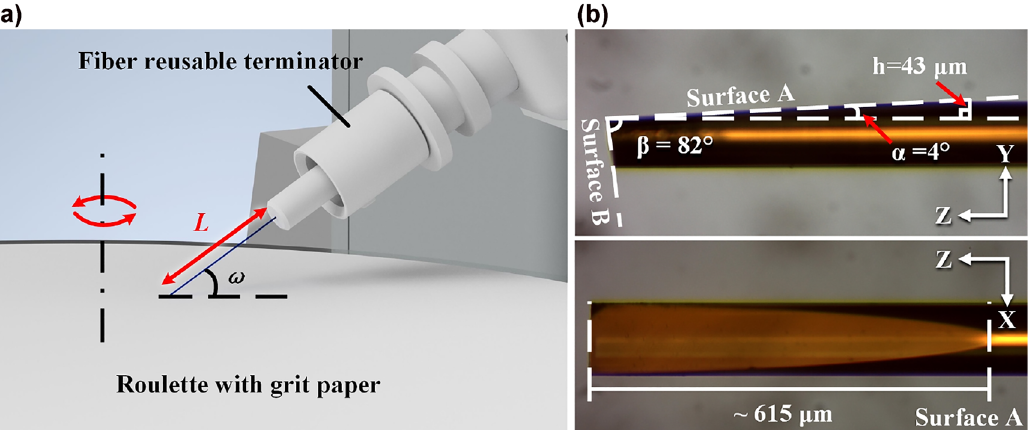
Figure 4: Grinding method and micrographs of the sample: (a) Partially enlarged view of the grinding and polishing system. The red double-arrow straight line and red circular arrow indicate the length of the fiber to be grinded and the rotation direction of the roulette, respectively; (b) micrographs of the wedge-shaped fiber tip after plating gold film. The white dotted lines are guided for